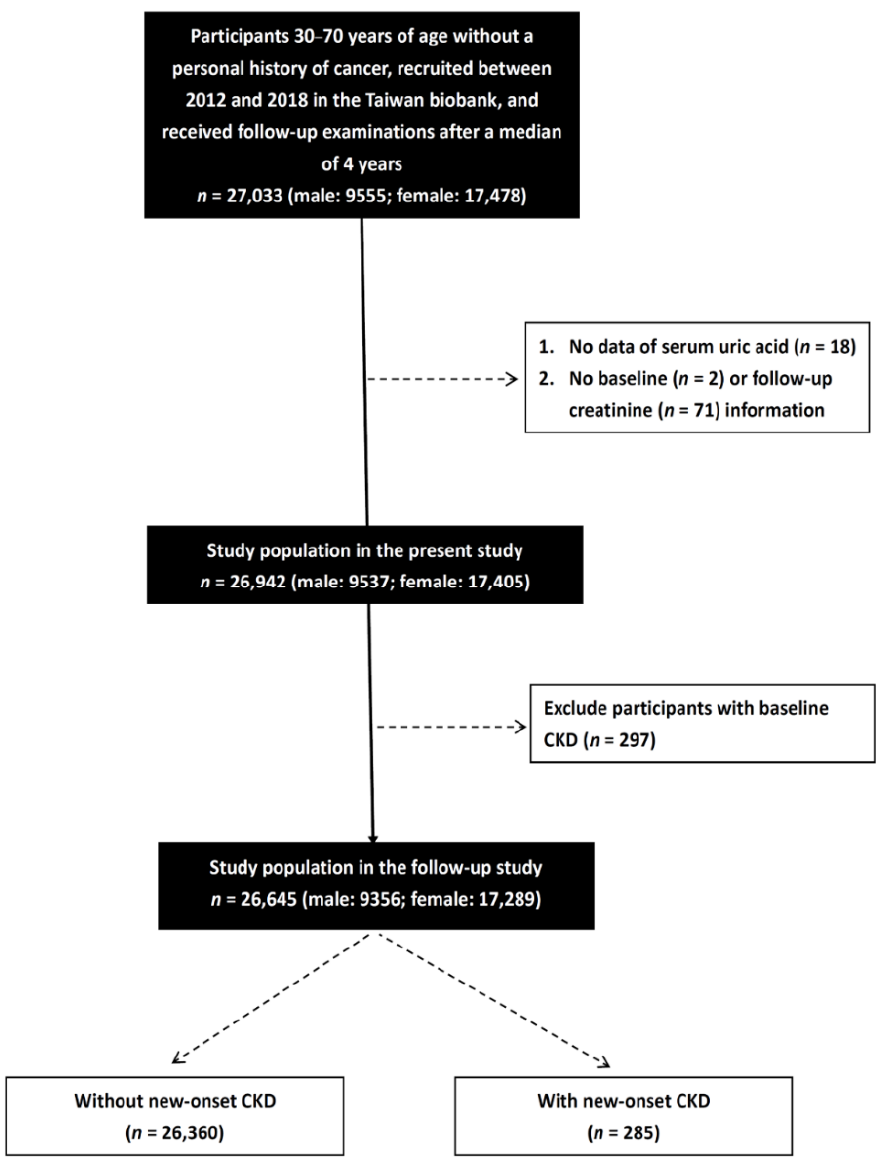
Figure 1. Flowchart of study population.